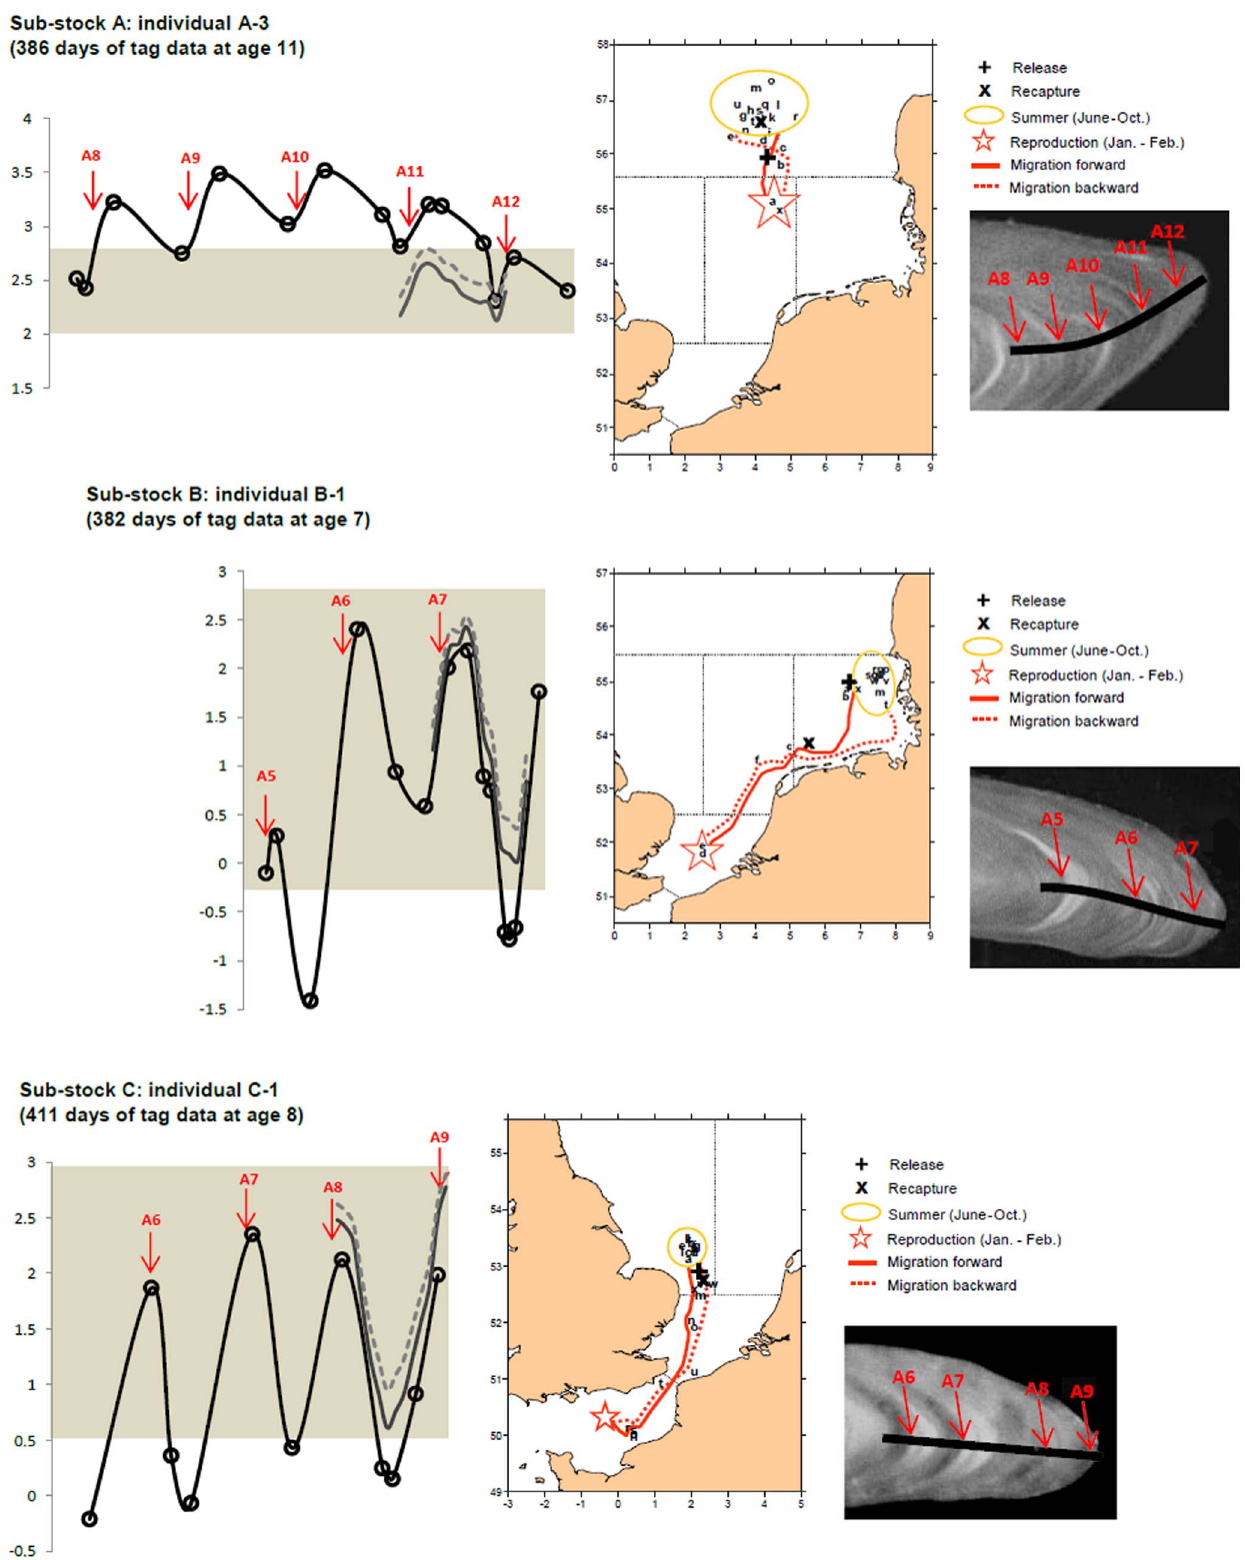
Figure 5. Intra-annual patterns of otolith d 18 O variation. Multi-annual seasonal variations of adult otolith d 18 O records (black line with spots, graph) measured with Secondary Ion Mass Spectrometry (SIMS) in 3 individuals representative of their sub-stock (A, B or C - see Fig. 1), shown with matching d 18 O values predicted from in situ tag data using the equation of Kim et al . 2007 for inorganic aragonite (plain grey line, graph) or that of Geffen 2012 for juvenile plaice (dotted grey line, graph). The shaded boxes (graph) indicate fish-specific range of daily tag-predicted d 18 O values